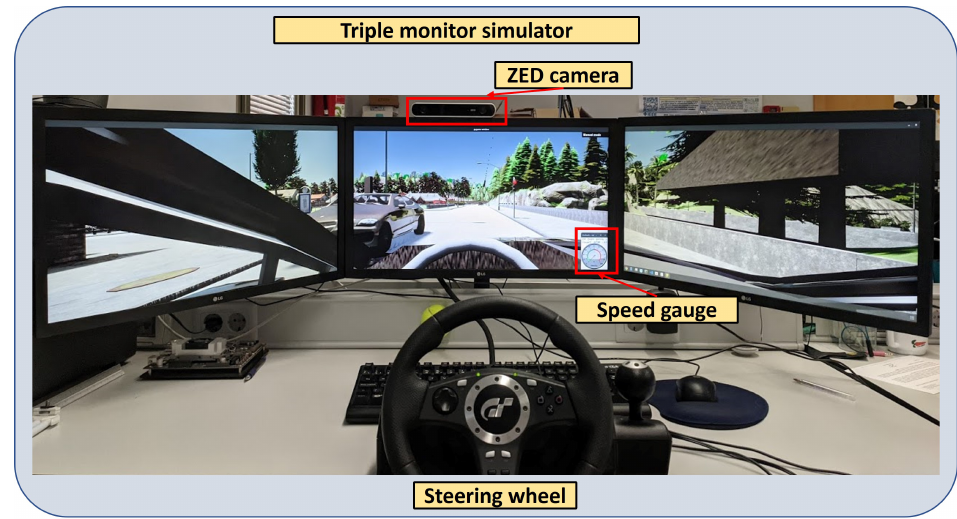
Figure 4. Point of view of the driver during the